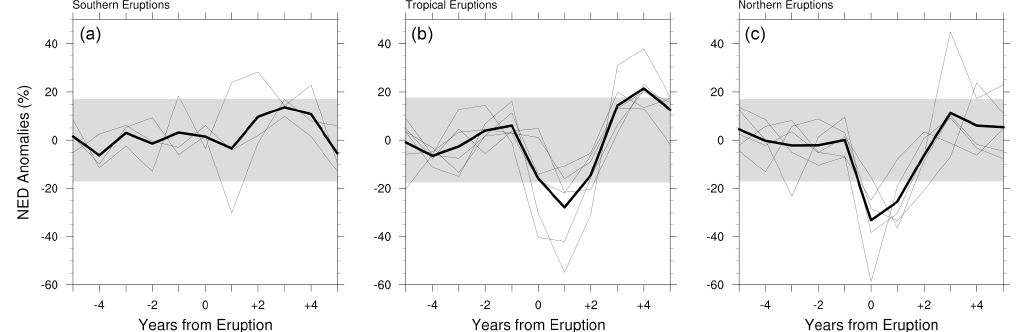
Figure 4. Percentage anomalies of NED in CESM-LME for (a) Southern Hemisphere, (b) tropical and (c) Northern Hemisphere volcanic eruptions from 850 to 1900 (bold eruption years in Table 1). Zero denotes the year of eruption. Thin black lines show the ensemble-mean anomalies for every eruption, and the thick black line shows the multi-eruption mean response. Grey shading measures the ± 2 standard deviation of pre-eruption ( − 5 to − 1 years)